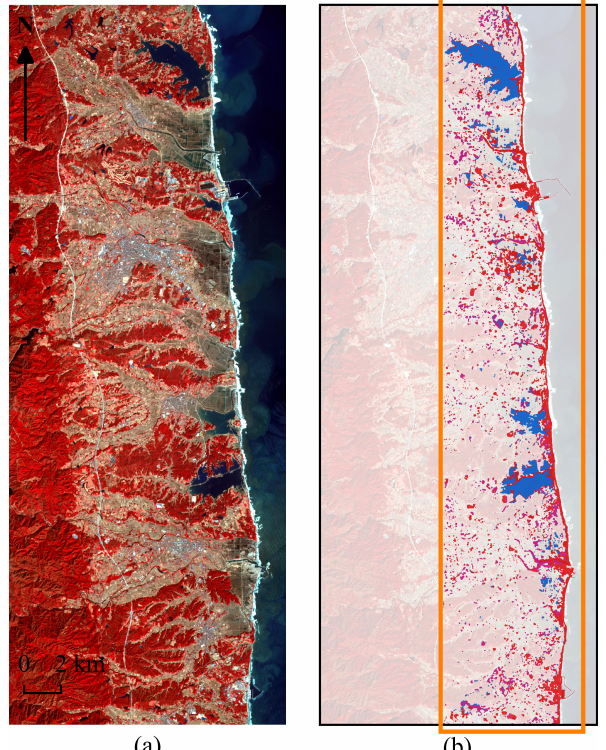
Figure 13. Results of Joint-Autoencoders and Deep Embedded clustering on ASTER VNIR images: ( a ) Post-disaster image in false colors taken on 19 March 2011. ( b ) Damage assessment on the coastal area sorted into 3 classes, flooded area in blue, damaged and destroyed buildings in red, and other changes in purple. The image is from